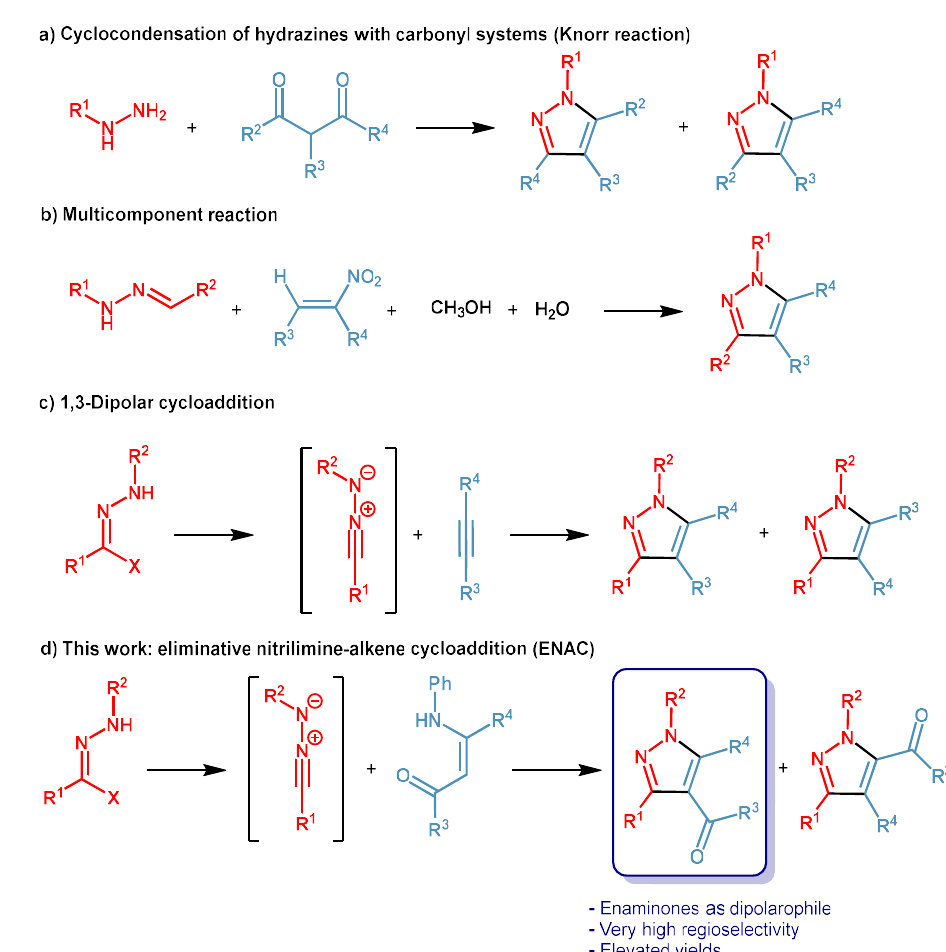
Scheme 1. Conventional approaches and our proposal for synthesis of tetrasubstituted